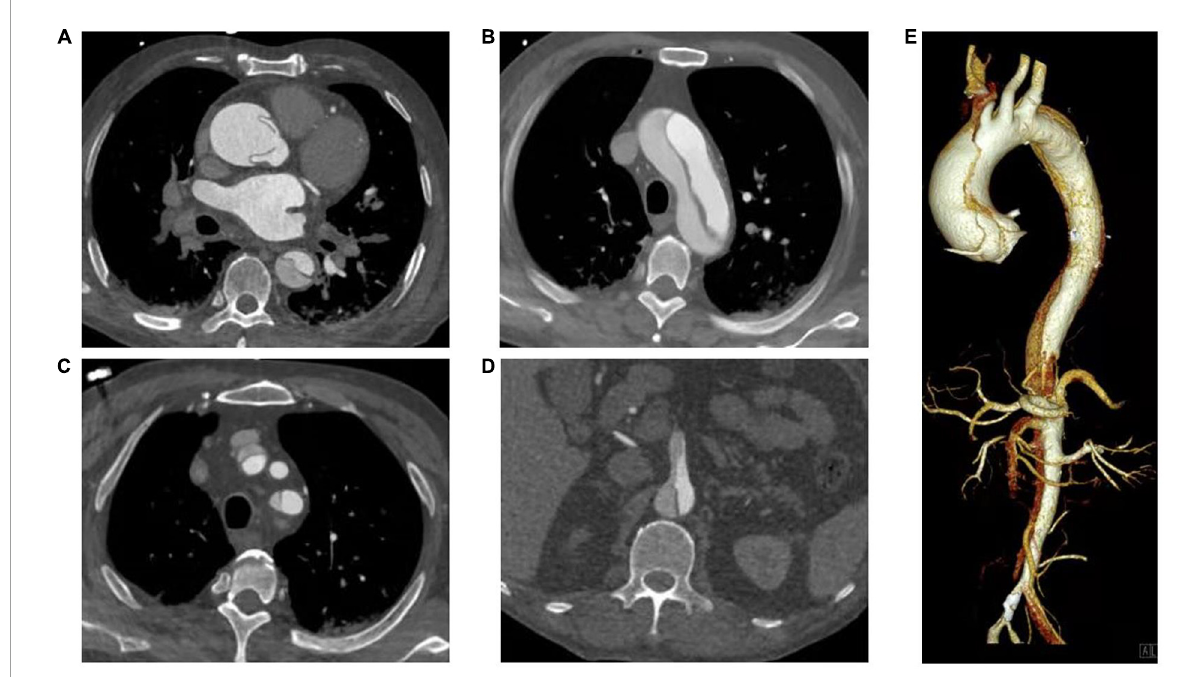
FIGURE1 CT Angiography of the Aorta. (A) Ascending aorta; (B) Aortic arch; (C) Branch of aortic arch (involving brachiocephalic trunk and left subclavian artery); (D) Aortic dissection involving superior mesenteric artery; (E) Volumetric CT scanning: 3D